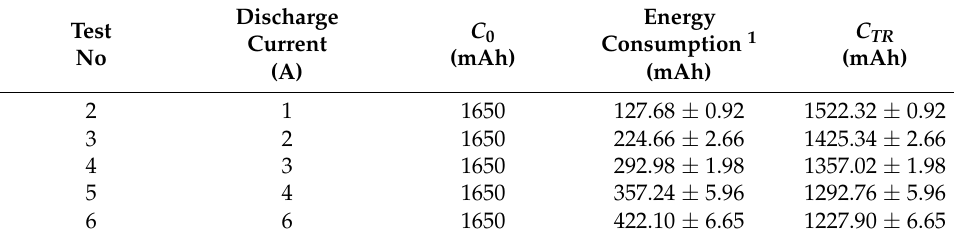
Table 3. Capacity variation during the thermal runaway process in Group ii.